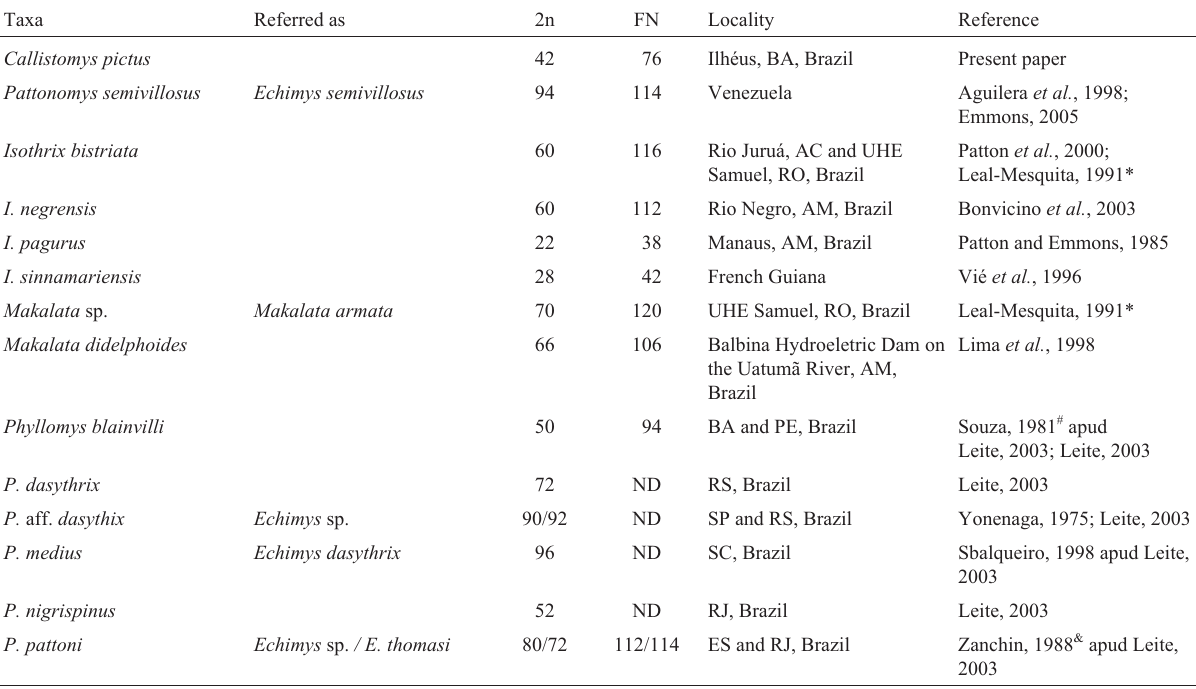
Table 1 - Karyotypes of Echimyinae taxa (Suborder